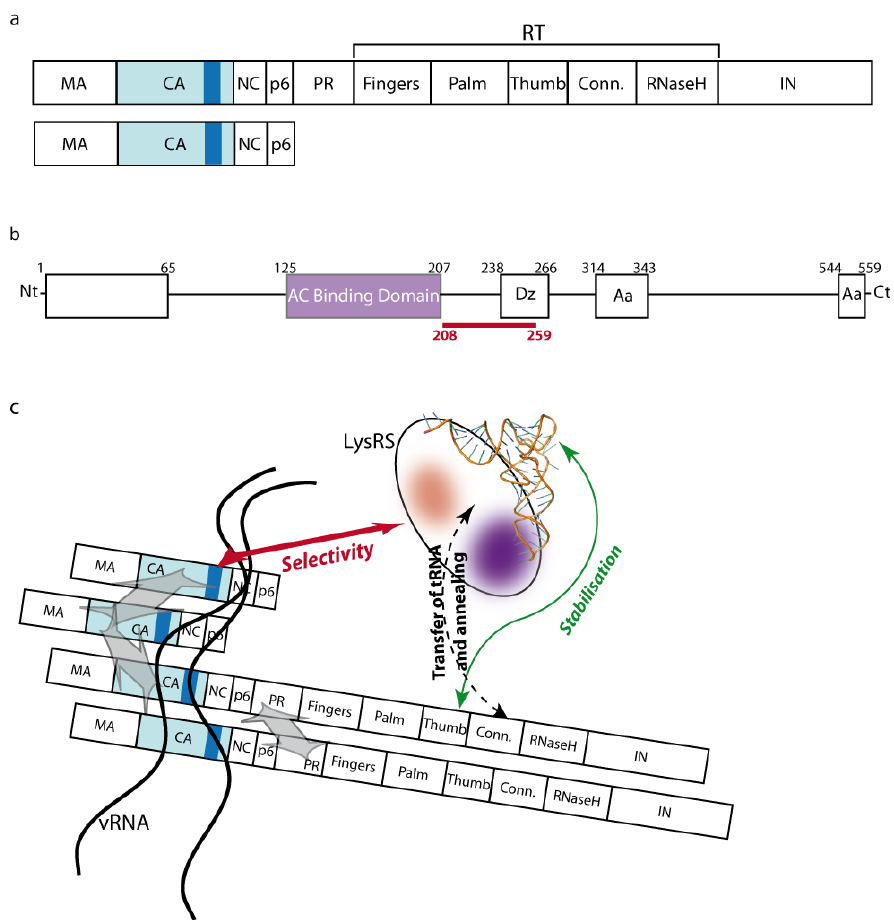
Figure 2. Partners and model for the tRNA 3Lys packaging complex (a) Organisation of the Gag-Pol and Gag precursors. MA: matrix ; CA: capsid ; NC: nucleocapsid ; p6: HIV-1 p6 protein ; PR: protease; RT: reverse transcriptase, with its Fingers, Palm, Thumb, Connection (Conn.) and RNase H domains; IN: integrase. The dark blue rectangle in the capsid domain of the precursors corresponds to the C-terminal helix 4 that was shown to interact with lysyl-tRNA synthetase (LysRS) (b) Organisation of LysRS: the anticodon (AC) binding domain is located between positions 125 and 207 and the LysRS dimerisation (Dz) domain between positions 238 and 266. The two boxes toward the C- terminus of the protein, between positions 314 and 343 and 544 and 559 are important for amino acid recognition. The area highlighted in red (208-259), overlapping the dimerisation domain, is involved in binding to the capsid. (c) Model for the packaging complex. The purple patch corresponds to the anticodon binding domain and the red patch to amino acids 208-259 that interact with the CA domain of